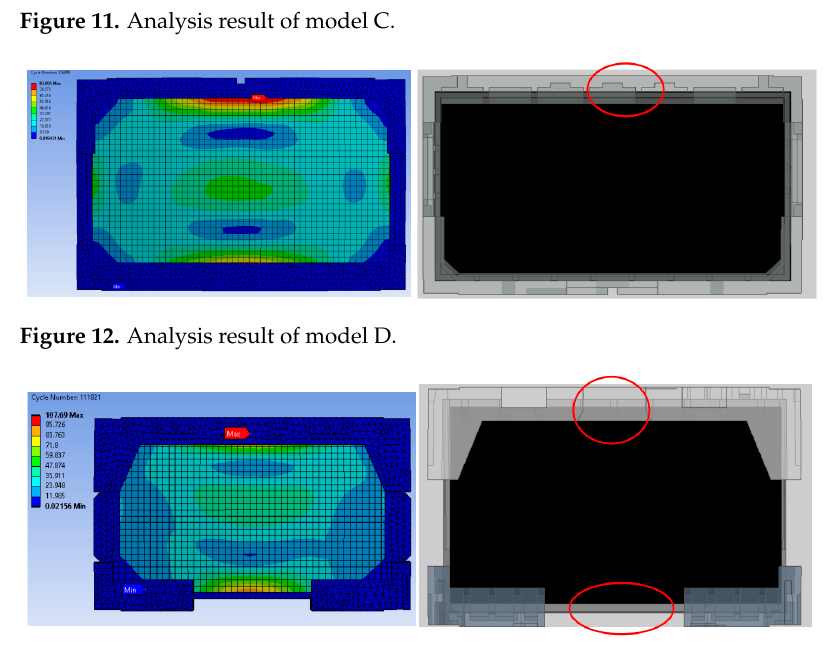
Figure 13. Analysis result of model E.